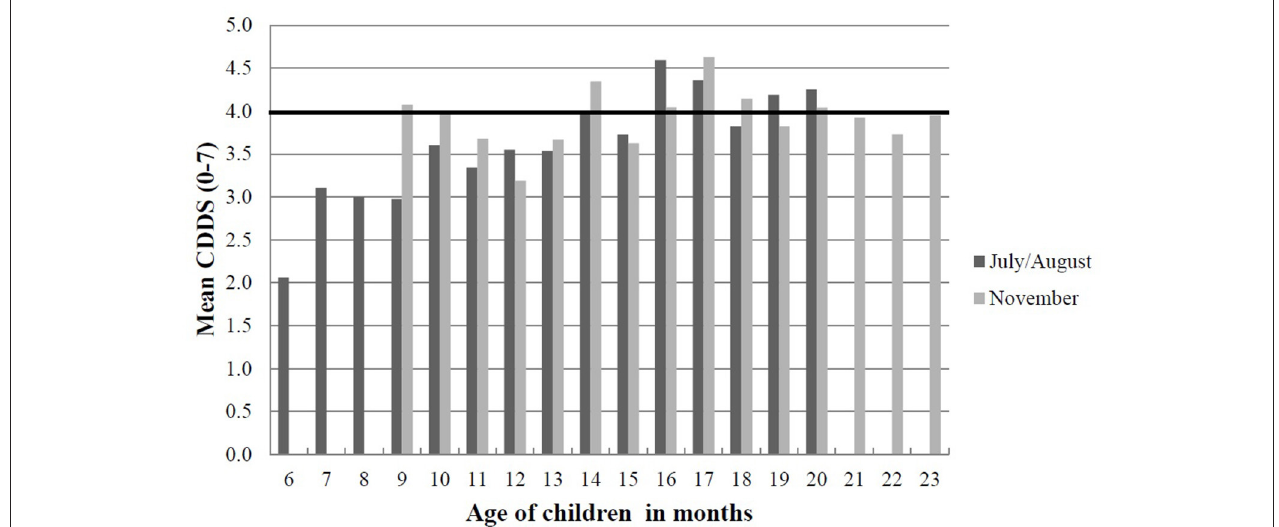
FIGURE 4 | Mean CDDS of children below 2 years stratified by age in months in July/August and November 2012 in Western Kenya. The black horizontal line indicates the threshold for minimum dietary diversity that 6–23 months old children should achieve from their diets according to WHO (51). The data presented is from a cohort of children ( n = 426) who were aged 6–20 months in July/August and 9–23 months in November; thus, there were no children included aged 21–23 months in July/August and 6–9 months in November. CDDS, children’s dietary diversity score.